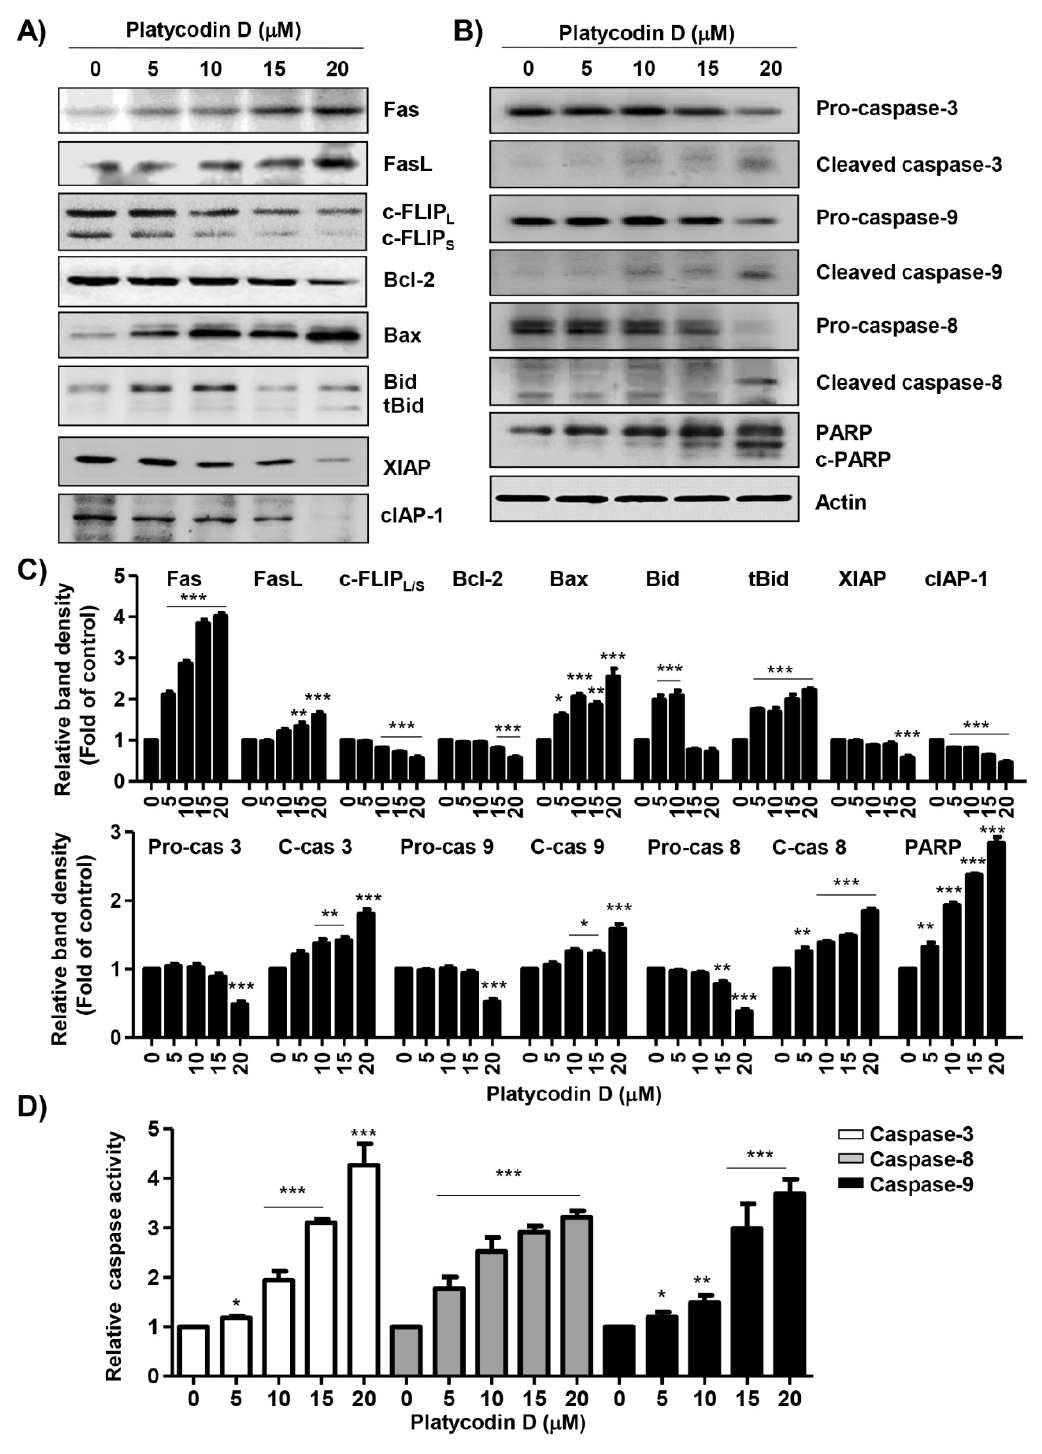
Fig. 2. The effects of PD on the expression of DR-related and Bcl-2 family members, and caspases in PC3 cells. PC3 cells were stimulated with different concentrations of PD for 48 h. (A and B) After treatment with the indicated concentrations of PD for 48 h, Western blotting was then performed using the indicated antibodies and an ECL detection system. Actin was used as an internal control. (C) The expression of each protein was indicated as fold change with control. (D) The activities of caspase-8, -9 and -3 were examined using colorimetric caspase assay kits. (C and D) Each bar indicated the mean ± SD of three independent experiments ( ∗ P < 0.05, ∗∗ P < 0.01 and ∗∗∗ P < 0.001 compared to untreated